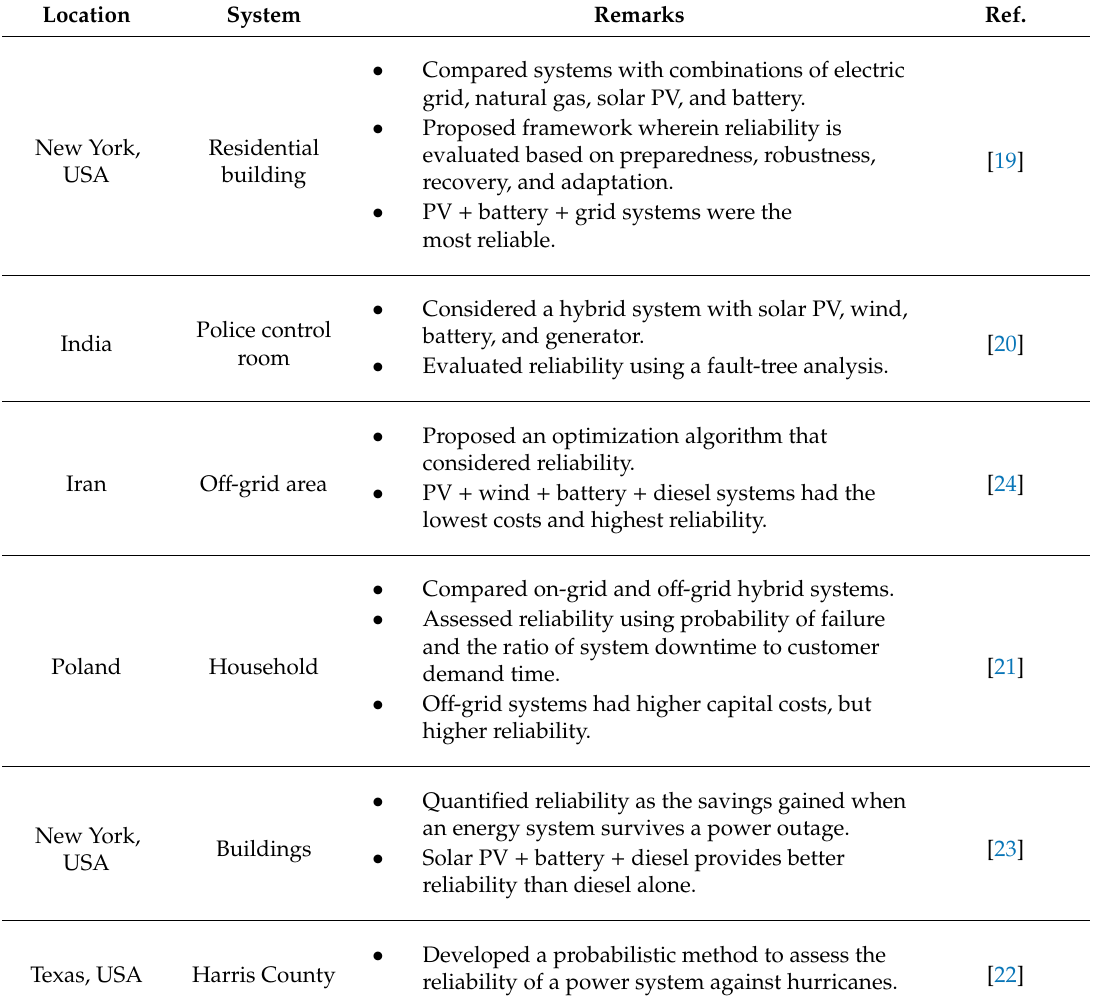
Table 2. Summary of studies about energy